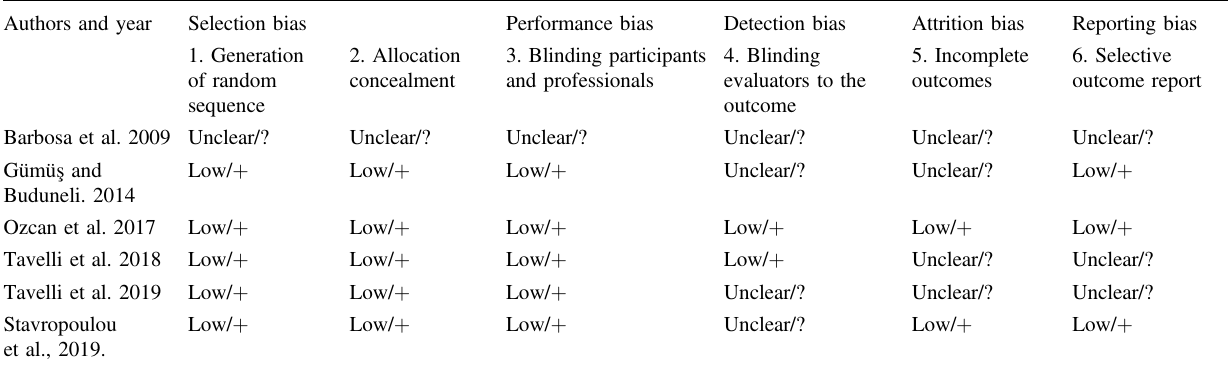
Table 4 Assessment of the quality and risk of bias of the included studies (RoB 1.0 tool, Cochrane Collaboration Manual) Authors and